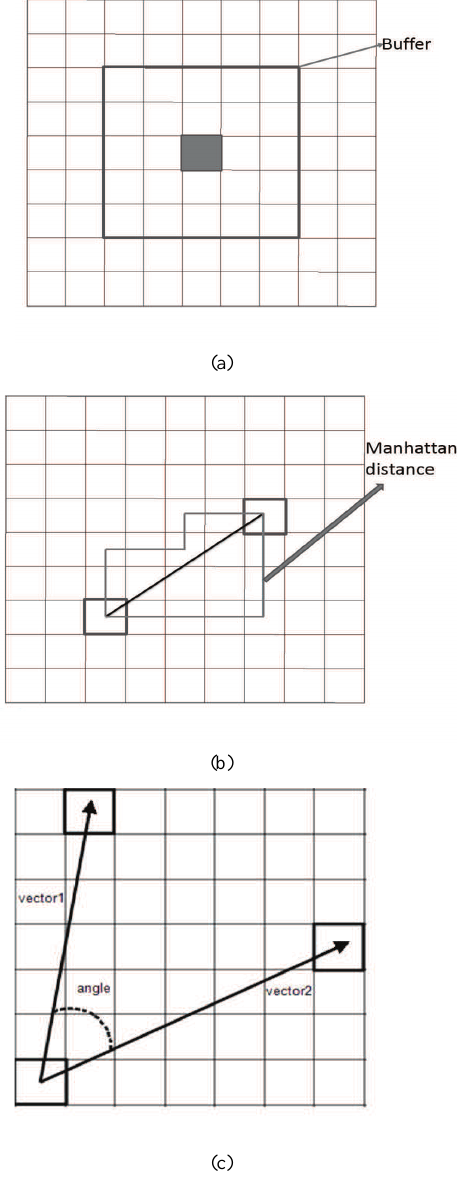
Figure 2: Buffer, Distance and Direction